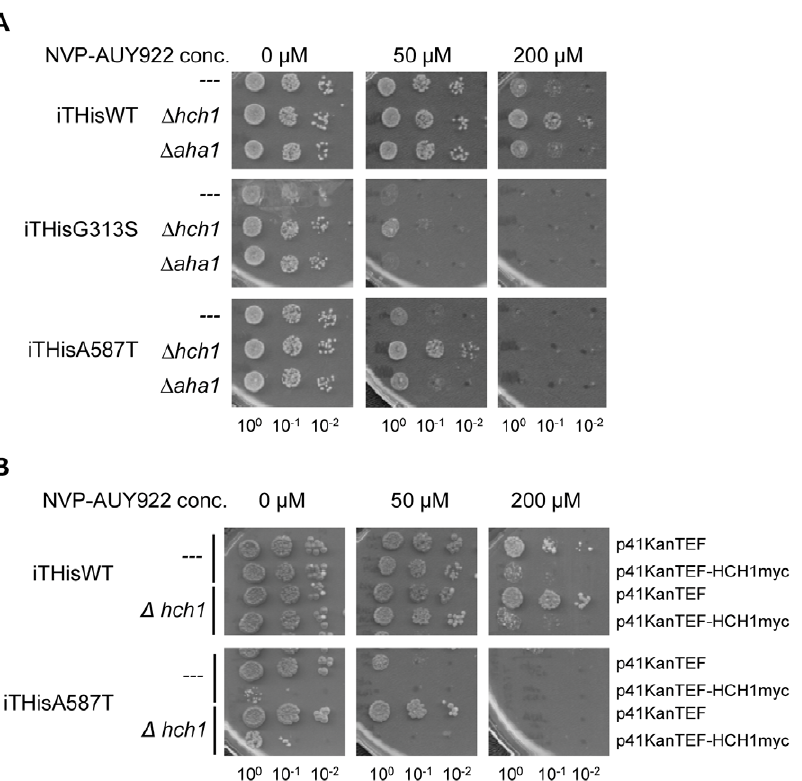
Figure 4. Hch1p regulates Hsp90 inhibitor drug sensitivity in yeast. A. Deletion of HCH1 confers resistance to Hsp90 inhibitor NVP-AUY922 in yeast expressing Hsp82p, Hsp82p G313S or Hsp82p A587T . Cells were grown overnight in YPD and then diluted to 1 6 10 8 cells per mL. 10-fold serial dilutions were prepared and 5 m L aliquots were spotted on YPD agar plates supplemented with indicated concentrations of NVP-AUY922. B. Overexpression of myc-tagged Hch1p results in hypersensitivity to Hsp90 inhibitor NVP-AUY922 in yeast. Cells were grown overnight in YPD supplemented with 200 mg/L G418 and then diluted to 1 6 10 8 cells per mL. 10-fold serial dilutions were prepared and 5 m L aliquots were spotted on YPD agar plates supplemented with 200 mg/L G418 and indicated concentrations of NVP-AUY922.